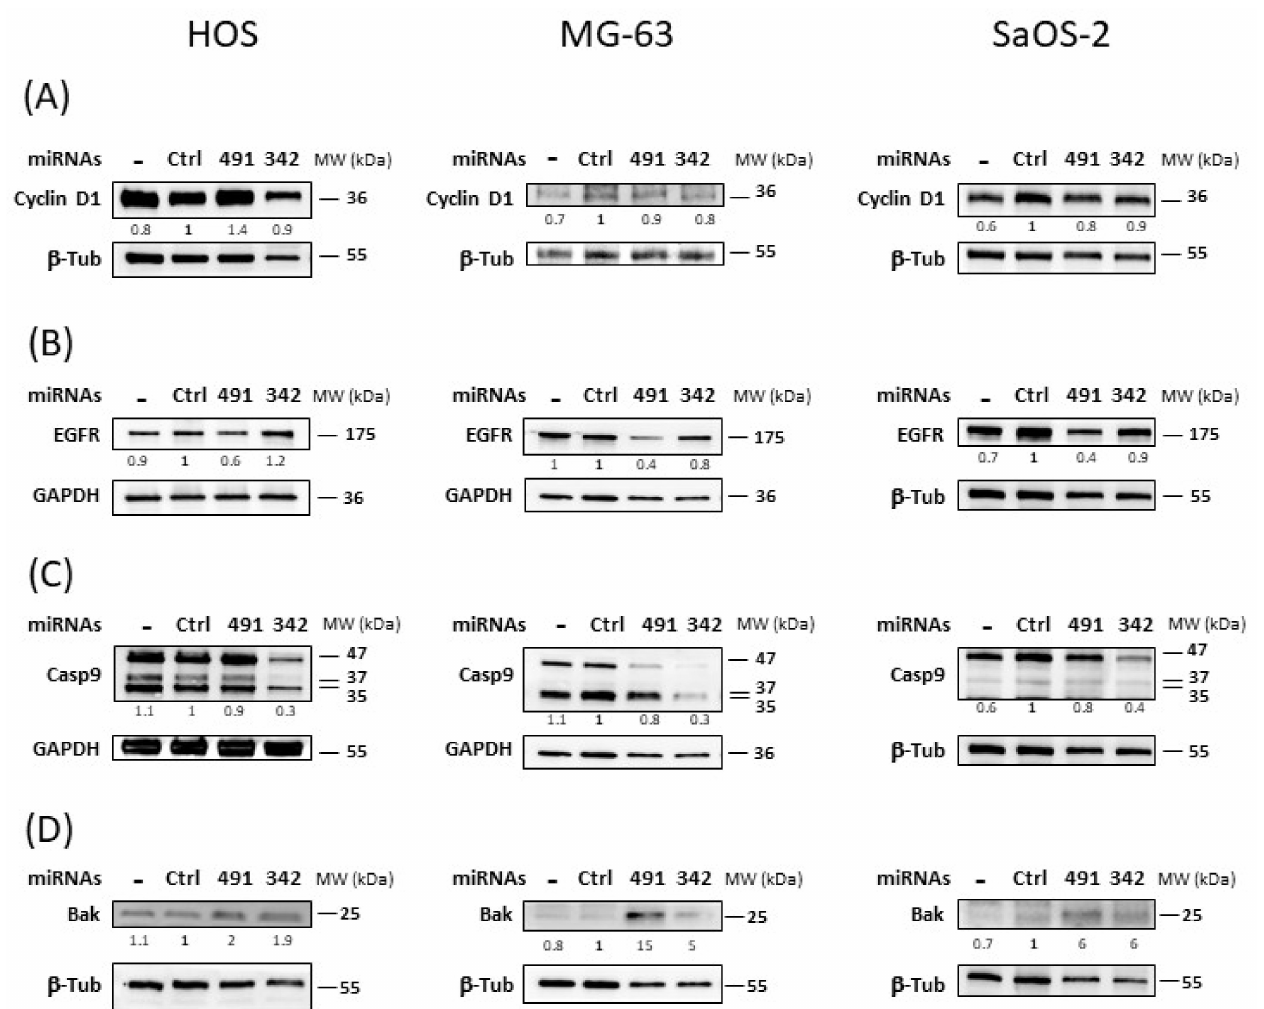
Figure 6. Analysis of some survival/death proteins affected by miR-491-5p and miR-342-5p in os- teosarcoma cell lines. HOS, MG-63 and SaOS-2 were cultured and transfected for 72 h as described in Figure 4. Protein extracts were analyzed by Western blotting for ( A ) cyclin D1, ( B ) EGFR, ( C ) caspase-9 and ( D ) Bak versus β -tubulin ( β -Tub) or GAPDH. Representative blots of three independent Western blots are shown. Quantification of the bands, normalized to β -tubulin or GAPDH signals and to miR-Ctrl, is shown below each